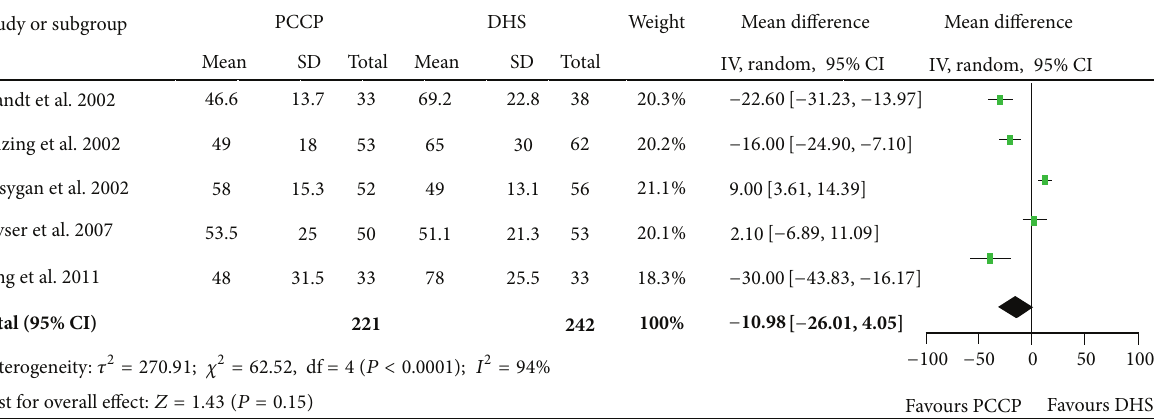
Figure 3: Comparison of operation time between PCCP and DHS.